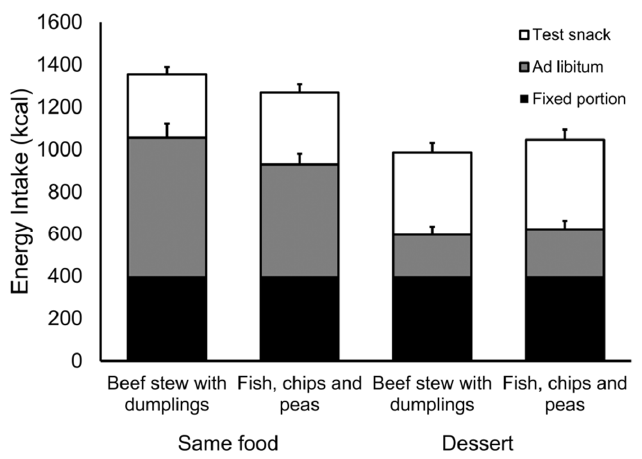
Figure 3. Mean (+S.E.) energy intake (kcal) of the fixed portion, ad libitum meal and snack food across conditions.